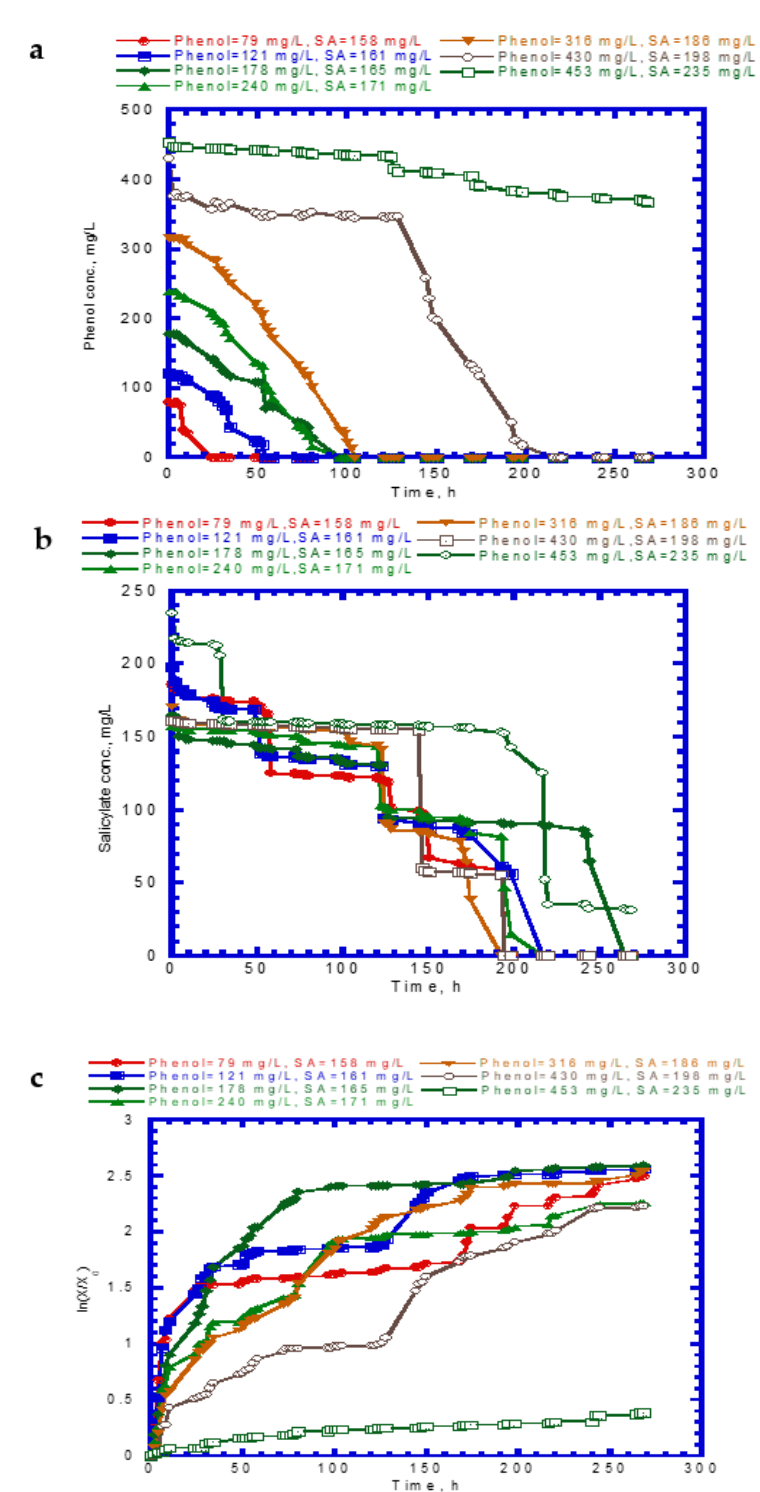
Figure 4. Variation of binary substrates with time: ( a ) phenol biodegradation, ( b ) salicylate biodegradation, and ( c ) cell growth.